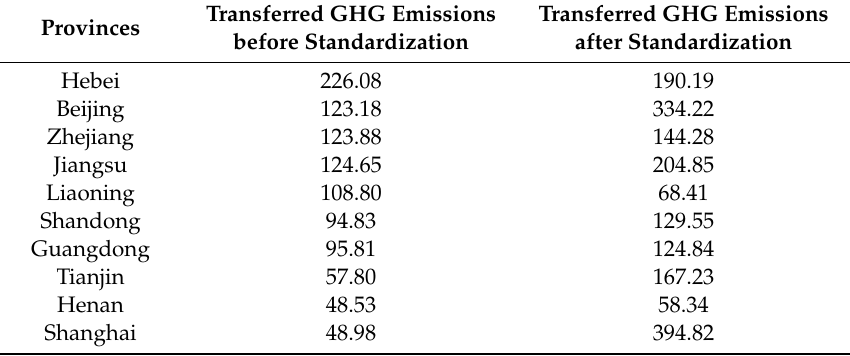
Table 4. Transferred GHG emissions before and after standardization (Unit: